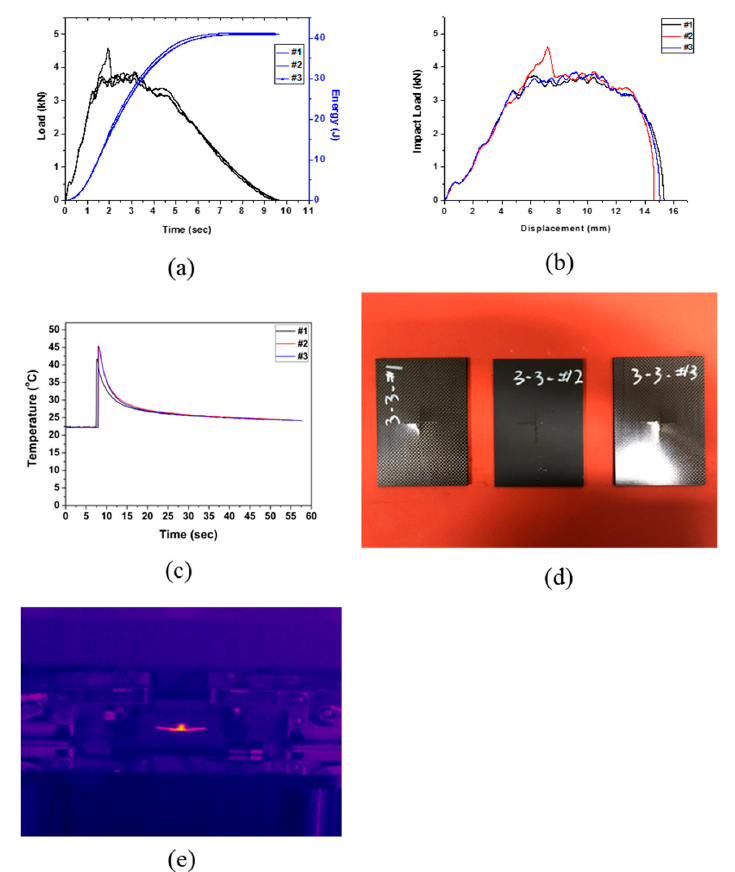
Table 7. Impact test results of Type 3.